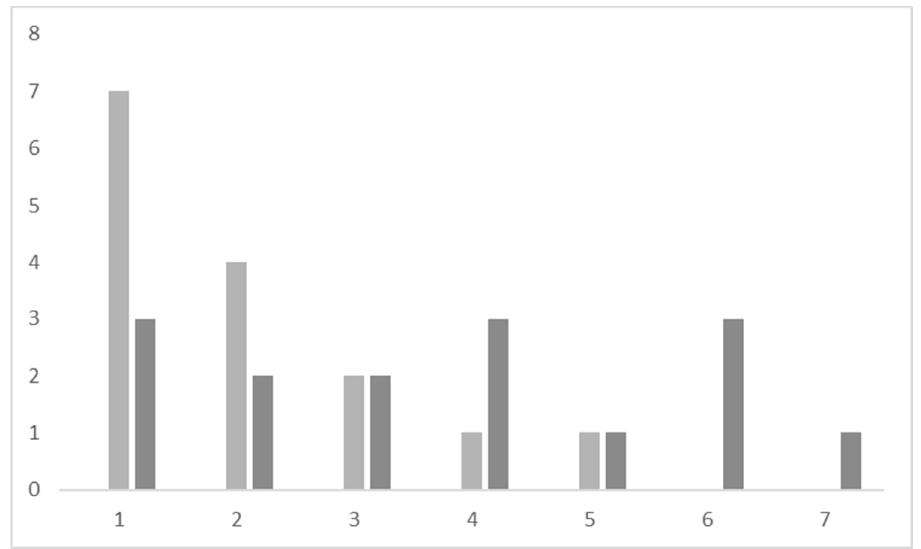
Figure 2. Participant willingness to eliminate ( light bars ) or reduce ( dark bars ) processed meat according to ranking on a Likert scale (1–7). The vertical axis refers to the number of participants. The horizontal axis refers to Likert scale.